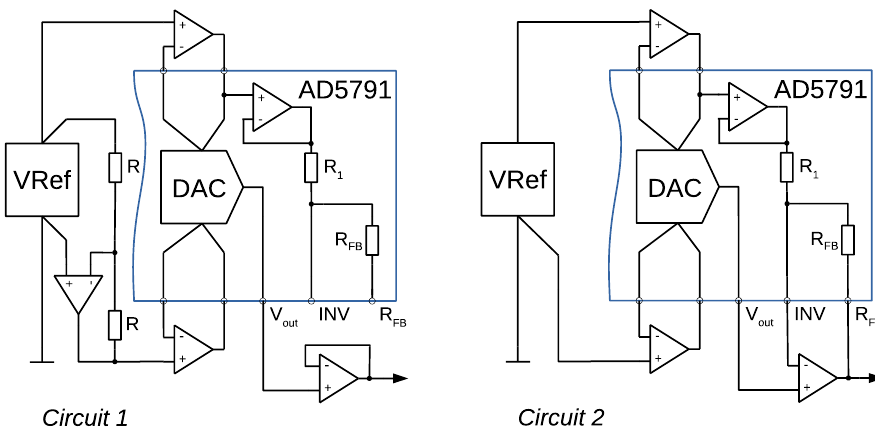
Figure 6. Digital-to-analog converter configurations. Table 3. Noise level of the digitally controlled current source.